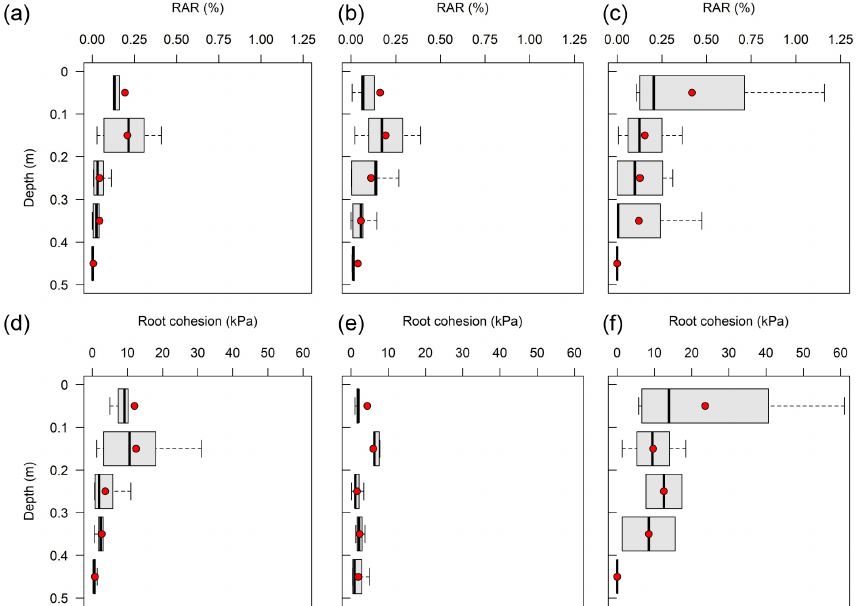
Figure 8. Root area ratio plotted against depth for (a) Norway spruce, (b) Scots pine and (c) European beech. Root cohesion plotted against depth for (d) Norway spruce, (e) Scots pine and (f) European beech. Red dots highlight mean RAR or root